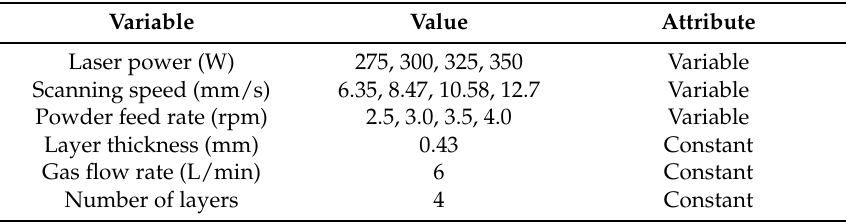
Table 2. Values of input variables.